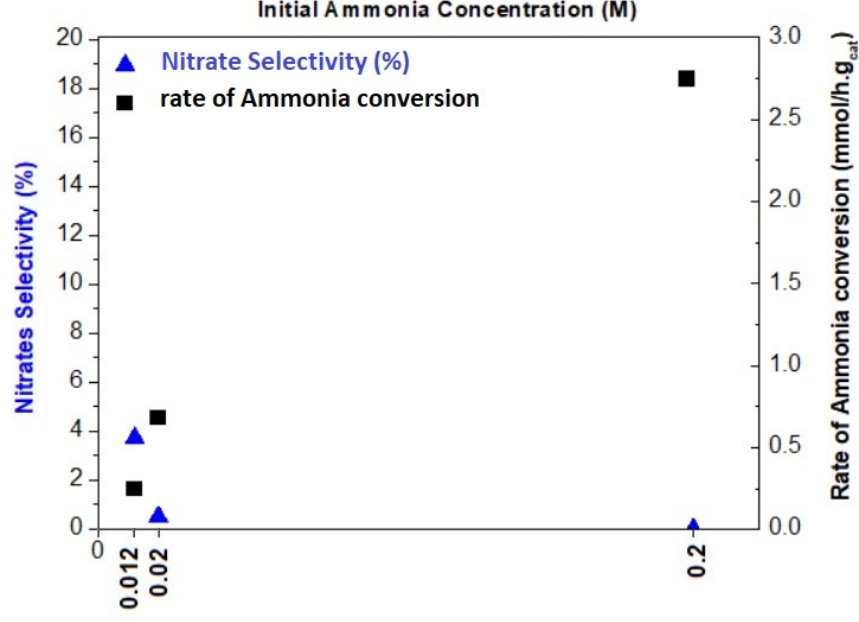
Figure 1. Rate of ammonia conversion and nitrate selectivity for the P25 sample at three different initial concentration of ammonia and constant pH of 5.1.